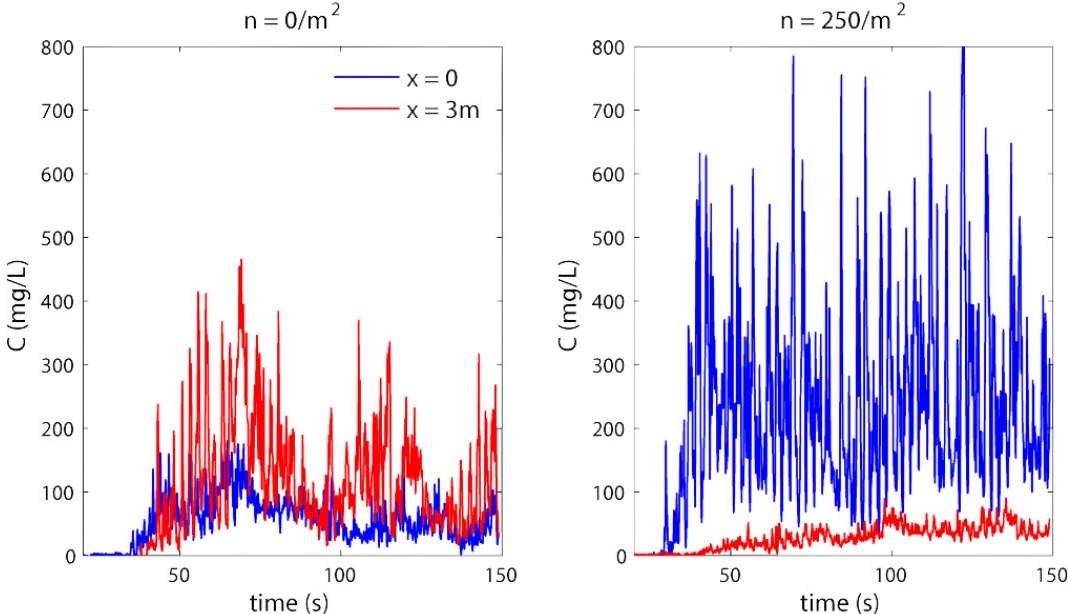
Figure 14. Time series of suspended sediment concentration for the non-populated (left) and densest (right) cases, at locations x c = 0m and x c = 3m, for waves H = 0 .